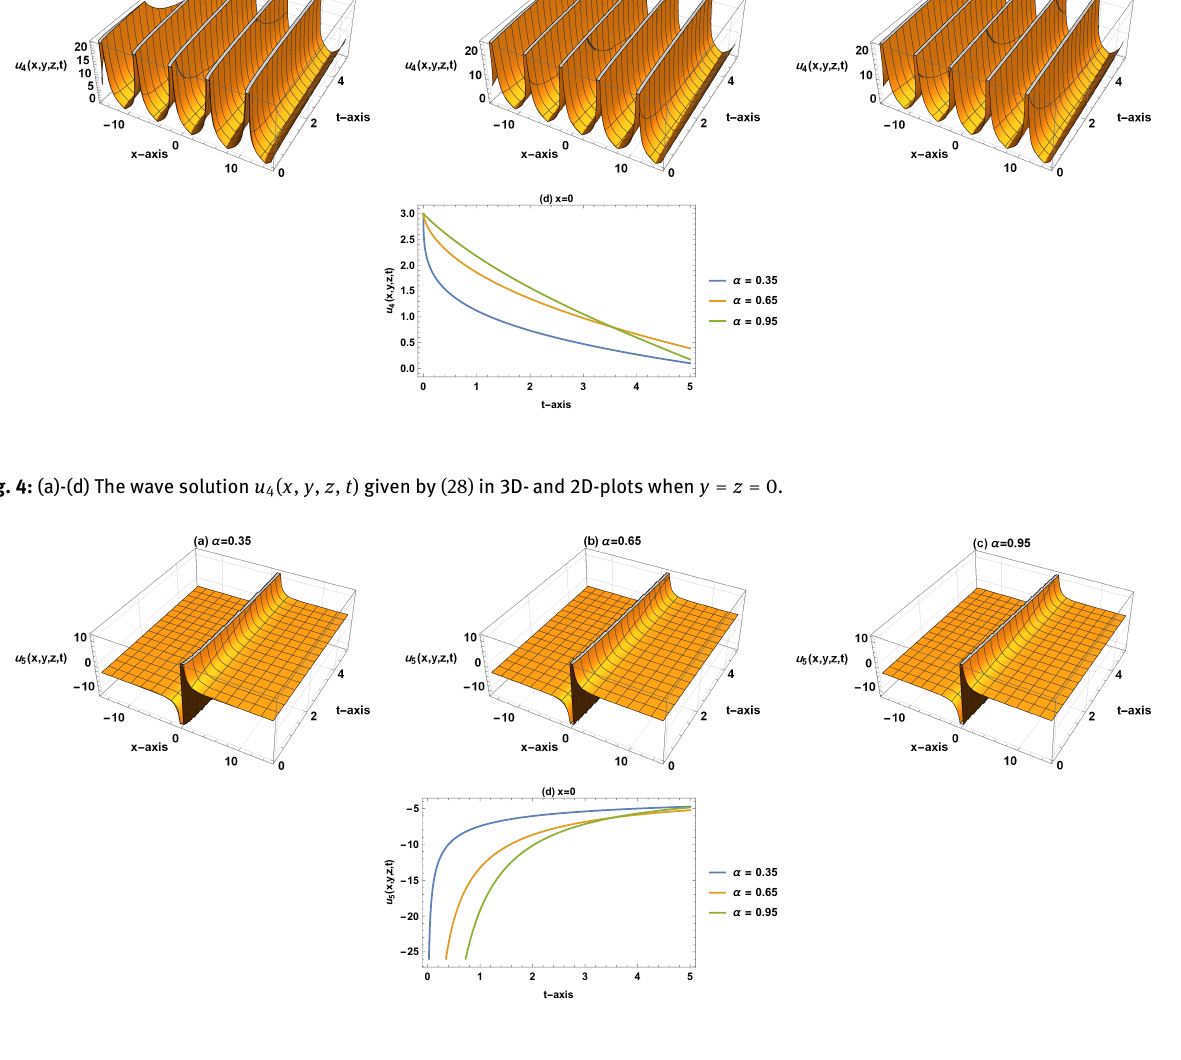
Fig. 5: (a)-(d) The wave solution u 5 ( x , y , z , t ) given by (31) in 3D-and 2D-plots when y = z = 0 .